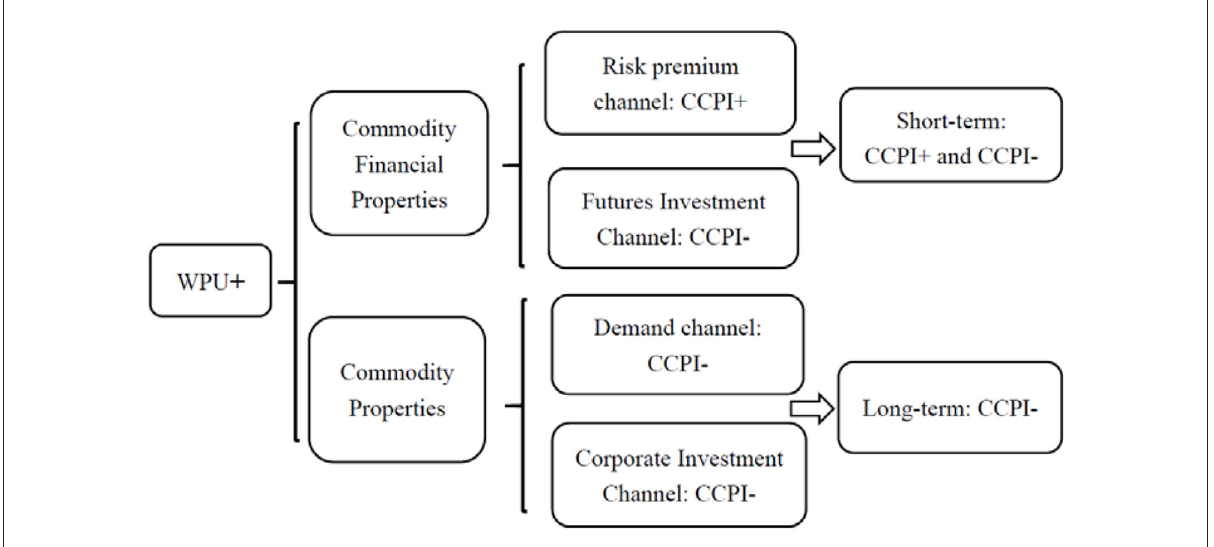
FIGURE1 Theoretical transmission mechanism of WPU affecting commodity